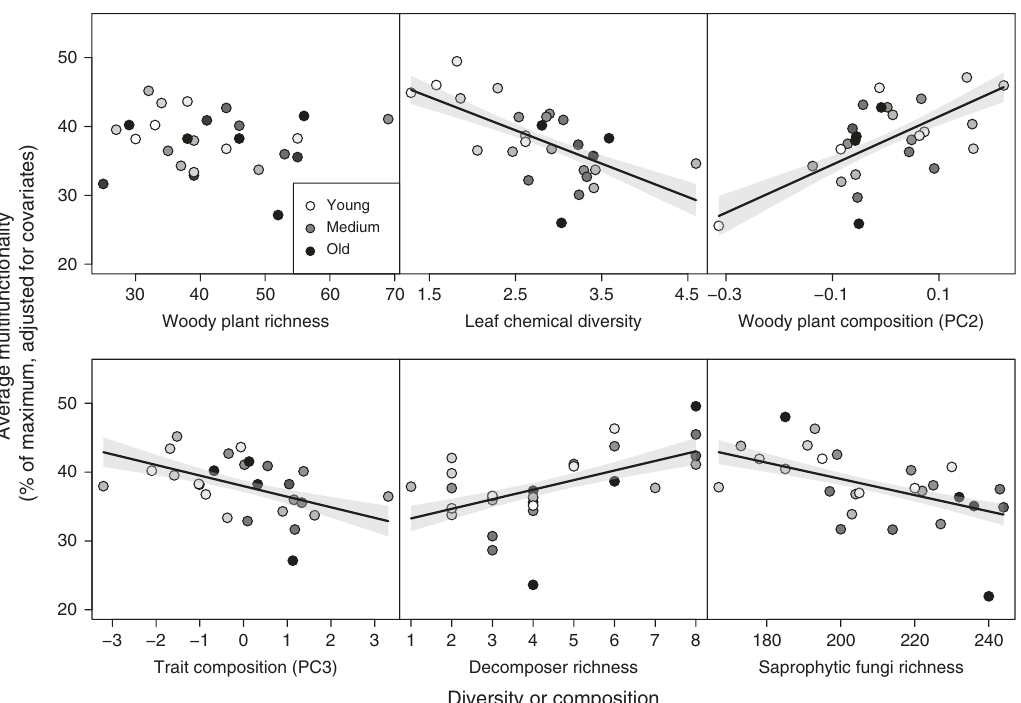
Fig. 1 Biodiversity effects on average multifunctionality. Multimodel-averaging results for effects of woody plant diversity and composition, and heterotrophic species richness on multifunctionality as the average of nine standardized ecosystem functions in a biodiverse subtropical forest. Only variables retained after model simpli fi cation and model averaging (as well as tree species richness for comparison) are shown. Values on the x -axis represent either increasing diversity or differences among study plots in species or functional-trait composition. Note that y -axis values show data adjusted for covariates (see Supplementary Fig. 11 for raw data). Regression lines ( ± 1 SE, fi tted across all 26 plots) are adjusted for covariates and indicate signi fi cant ( P ≤ 0.05) relationships. The stand age of the study plots is indicated by a continuous gradient from white (youngest plots ~20-year-old)